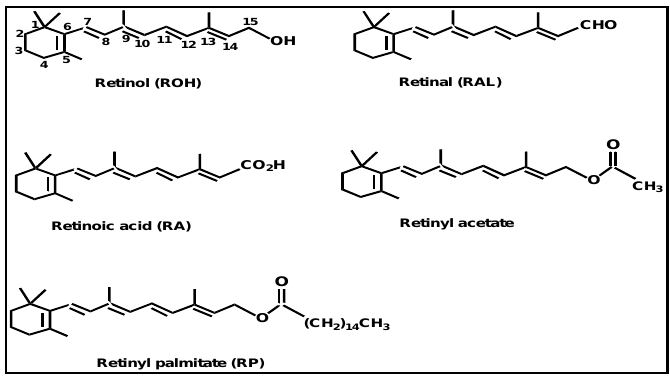
Figure 1: Names and numbering of